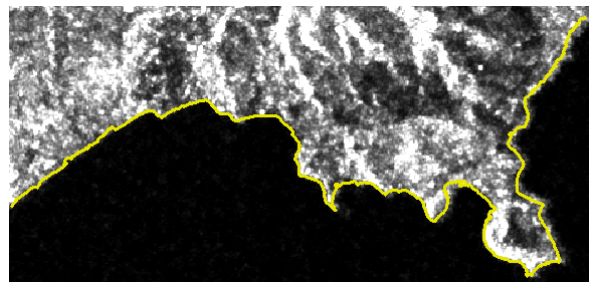
Figure 10. Extracted coastline from LIDAR data (yellow) The extracted coastline from LIDAR is shown in Figure 10.